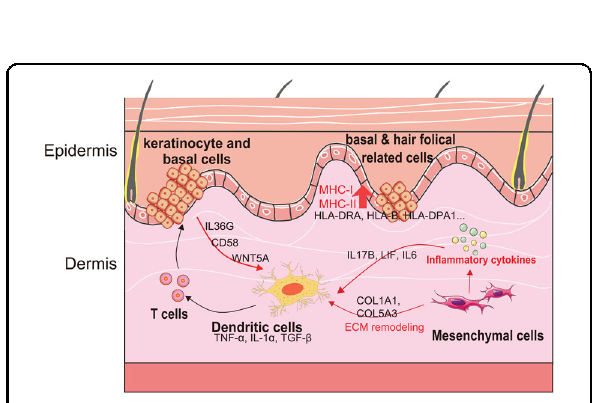
Fig. 5 Schematic view of the immune regulation from local resident epidermal cells and mesenchymal cells to DCs. Resident cells including basal cells, hair follicle-like cells, mesenchymal cells potentialize local in fl ammation by evoking MHC complex genes in psoriatic condition, and these cells can trigger dendritic cells for the in fl ammatory cascade through remodeling ECM and secreting cytokines such as LIF, IL-6, IL-17B, IL-36, and